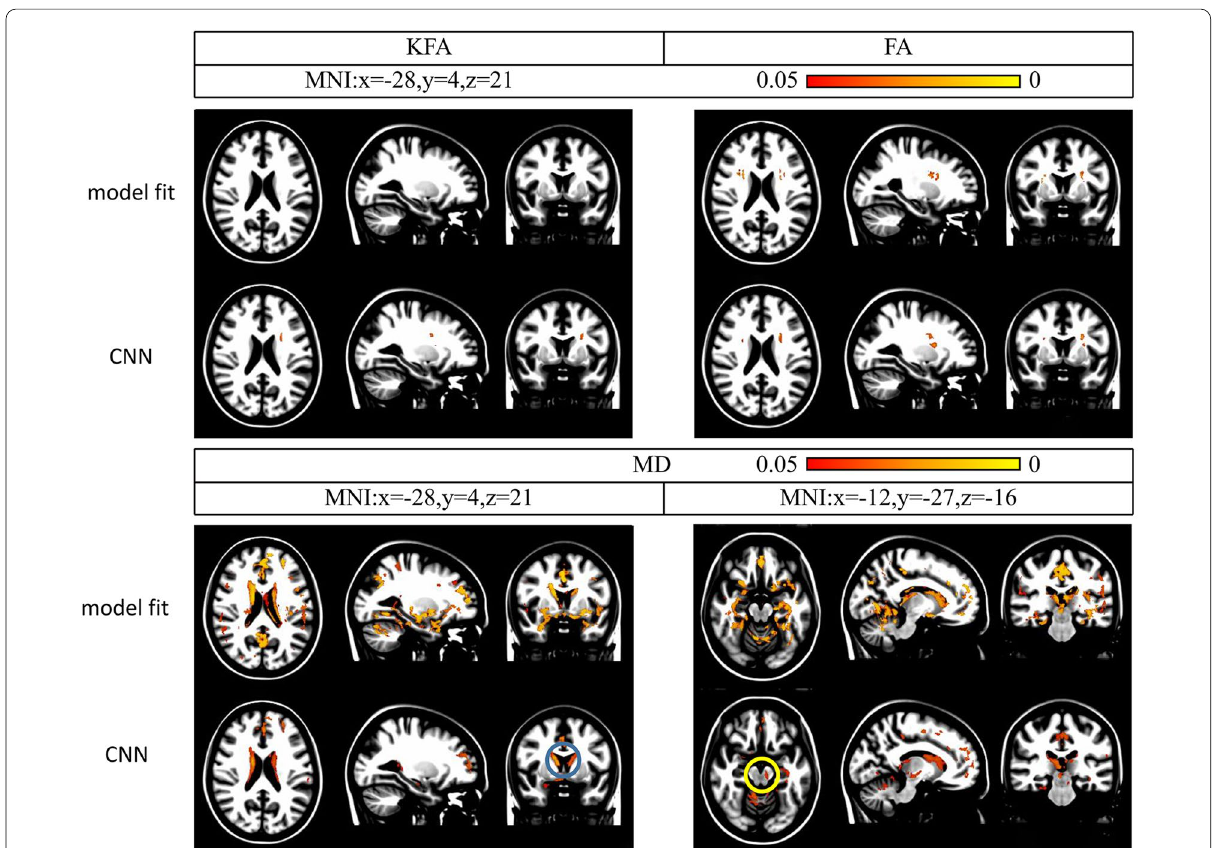
Fig. 4 Whole-brain unpaired t-test analysis of diffusion kurtosis imaging measures using the CNN-based and model-fitting methods. Note. Increased mean diffusivity (MD) values in the bilateral caudate (Cau) (blue circle) and right substantia nigra (SN) (yellow circle) with the CNN-based method between the healthy control (HC) and Parkinson’s disease (PD) groups ( p < 0.05, family-wise error-corrected). KFA, kurtosis fractional anisotropy; FA, fractional anisotropy; MNI, Montreal Neurological